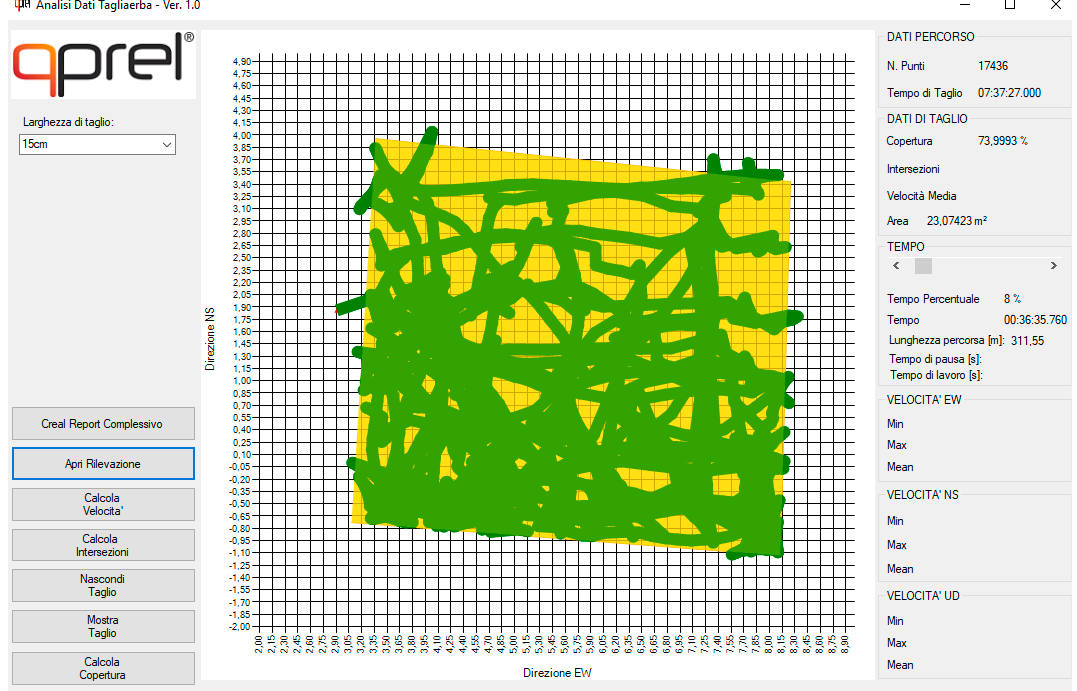
Figure 1. Custom-built software “Robot mower tracking data calculator” showing the percentages of turfgrass mown by the autonomous mowers Small 1 (green lines) at the 8% of the working time (on 18 June 2019) on Site A. The yellow area is the area with obstacles (extension: 23.04 m 2 ).